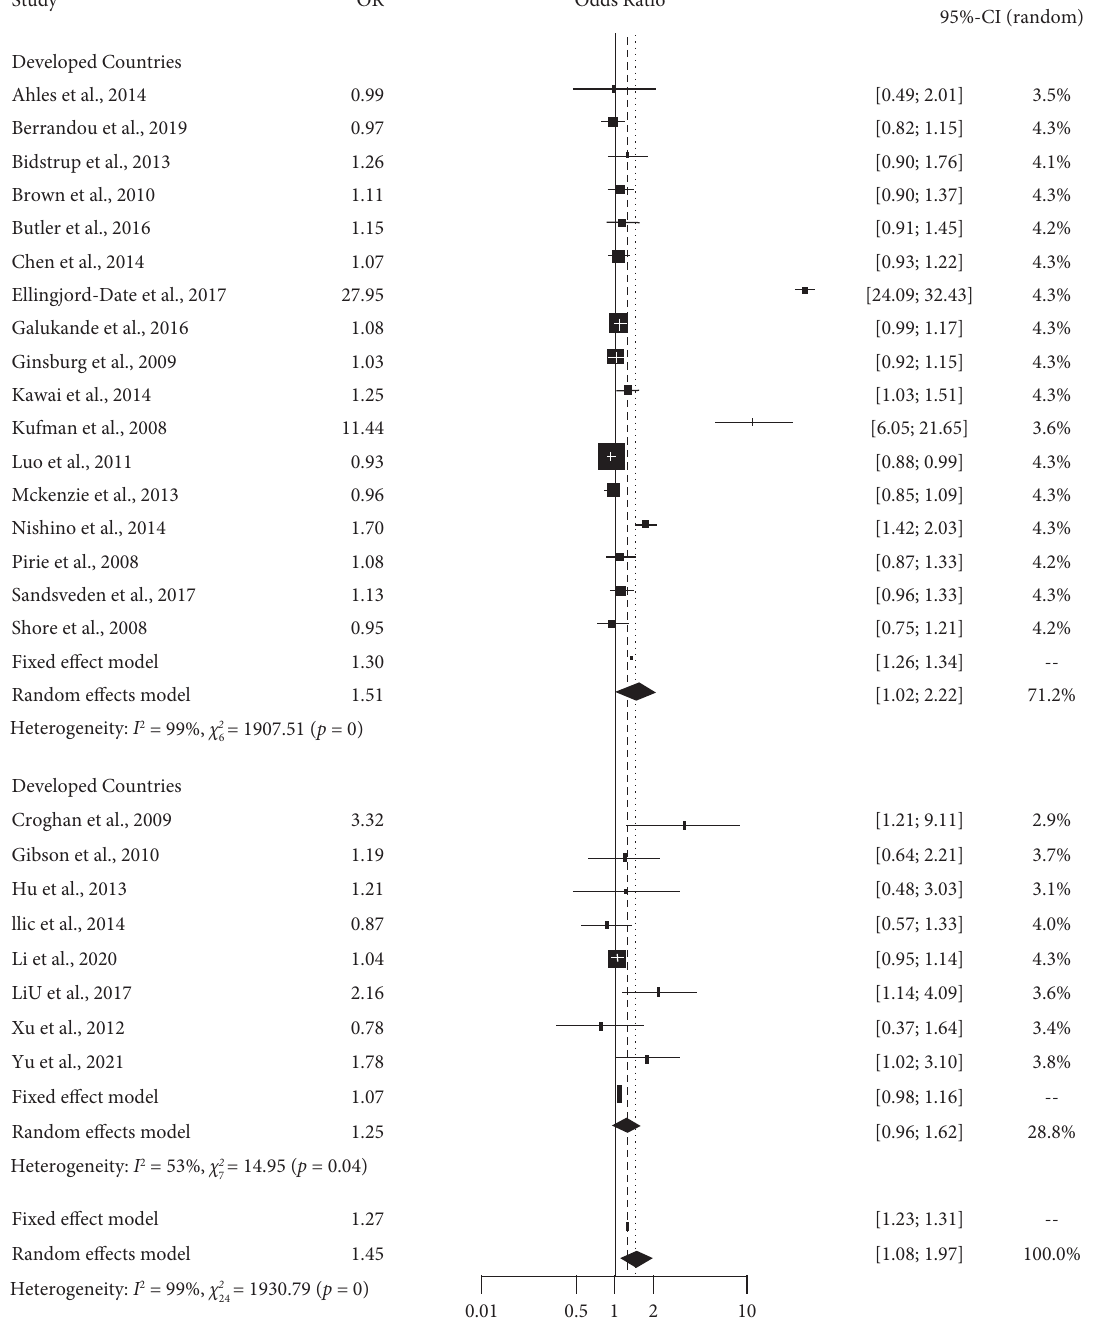
Figure 5: Forest plot showing subgroup analysis expressing the infuence of smoking by country status (developing or developed) on breast